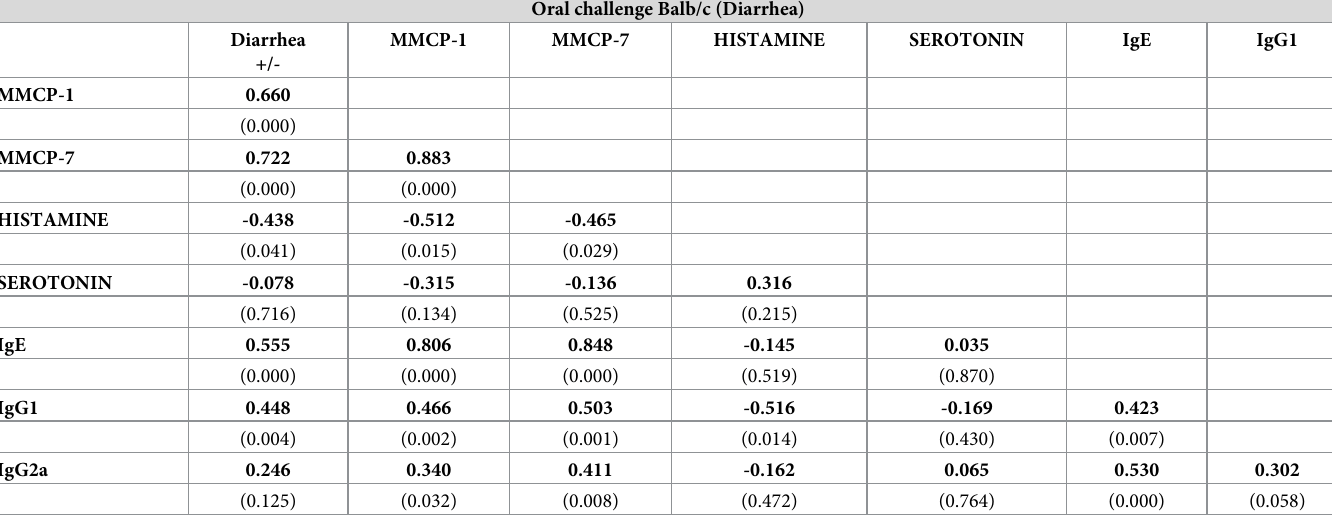
Bolded values indicate spearman correlation coefficient, values in brackets indicate p value.